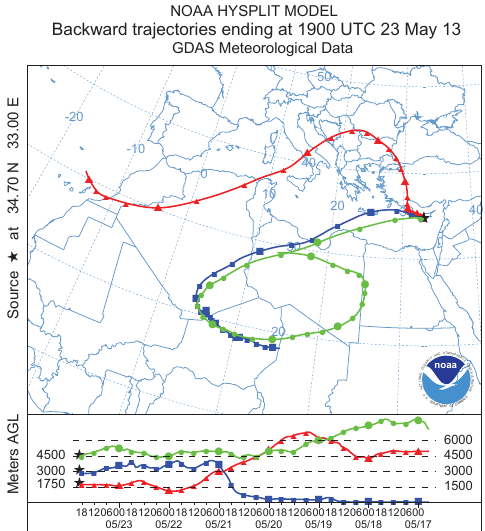
Figure 9. 7-day HYSPLIT backward trajectories arriving at Li- massol, Cyprus, at 1750m (red), 3000m (blue), and 4500m height (green) on 23 May 2013, 19:00UTC.